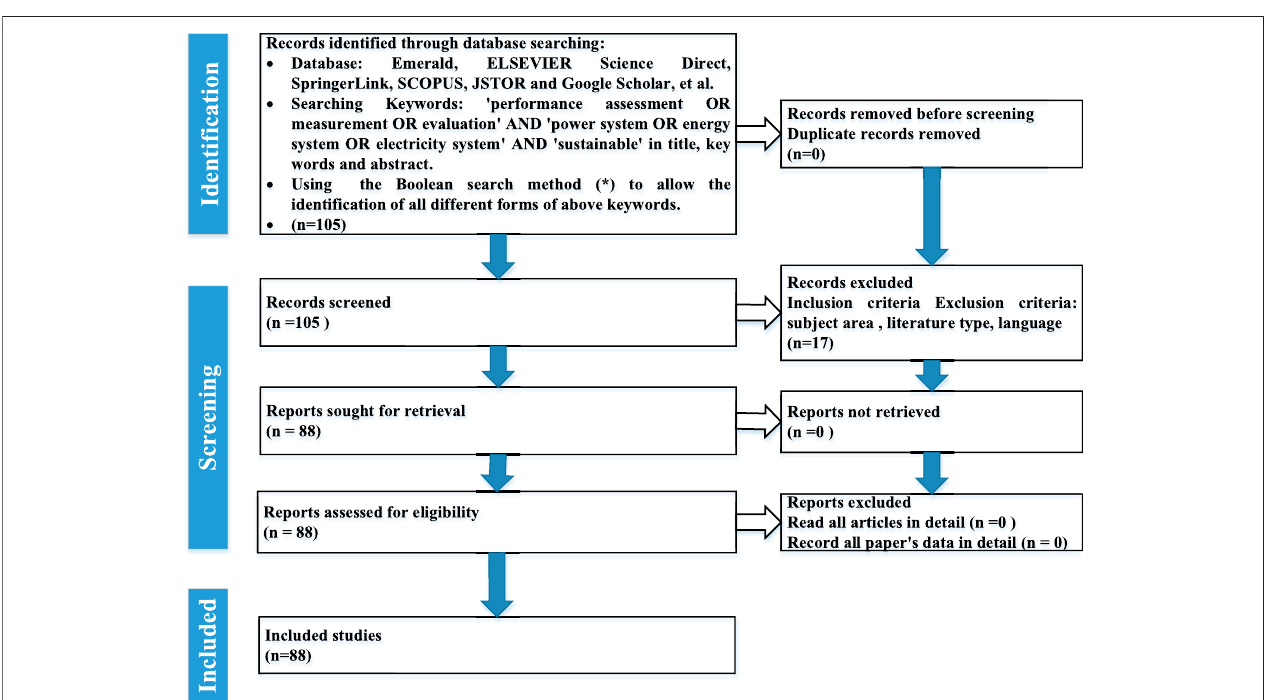
FIGURE 2 | PRISMA fl ow chart.